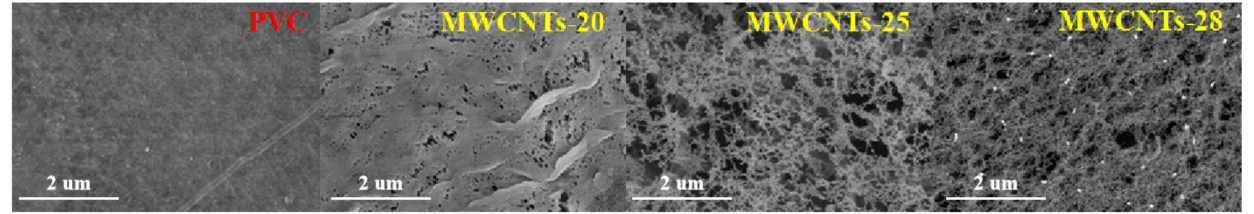
Figure 5. Surface SEM images of PVC, MWCNTs-20, MWCNTs-25, and MWCNTs-28 membranes.